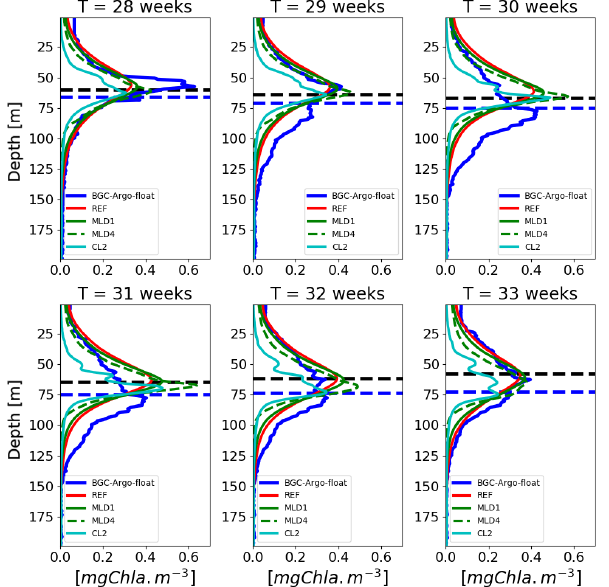
Figure 11. Example of a 6-week time series of vertical profiles from the lovbio035b BGC-Argo float (Fig. 4, from week 28 to week 33) based on diel variability and constant daily light descrip- tions, compared to BGC-Argo float Chl values (thicker blue line). The horizontal dashed blue line represents the euphotic depth z eu , whereas the dashed black line indicates the depth where measured PAR equals 5.8µmolphotonsm − 2 s − 1 as identified in Mignot et al. (2014). The legend reports model configurations listed in Table 1.